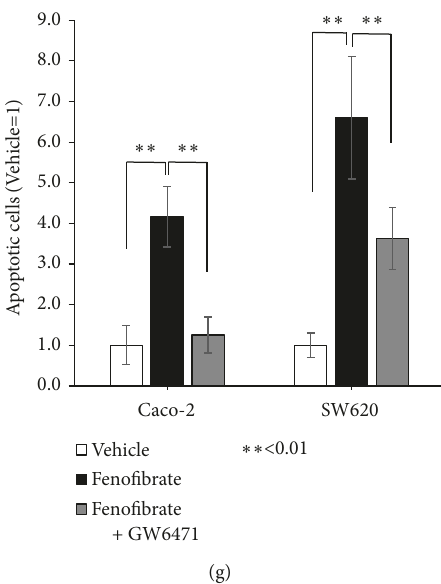
Figure 4: PPAR- 𝛼 activation affects apoptosis. (a) Control in Caco-2 cells (200 × ). (b) 100 𝜇 M of fenofibrate in Caco-2 cells (200 × ). (c) 100 𝜇 M of fenofibrate and 3 𝜇 M of GW6471 in Caco-2 cells (200 × ). (d) Control in SW620 cells (200 × ). (e) 100 𝜇 M of fenofibrate in SW620 cells (200 × ). (f) 100 𝜇 M of fenofibrate and 3 𝜇 M of GW6471 in SW620 cells (200 × ). (g) Human colorectal carcinoma cells (Caco-2 and SW620) were treated with 100 𝜇 M of fenofibrate, and 100 𝜇 M of fenofibrate and 3 𝜇 M of GW6471 for 48 h; apoptosis was determined by a Hoechst stain. Error bars indicate standard deviation.